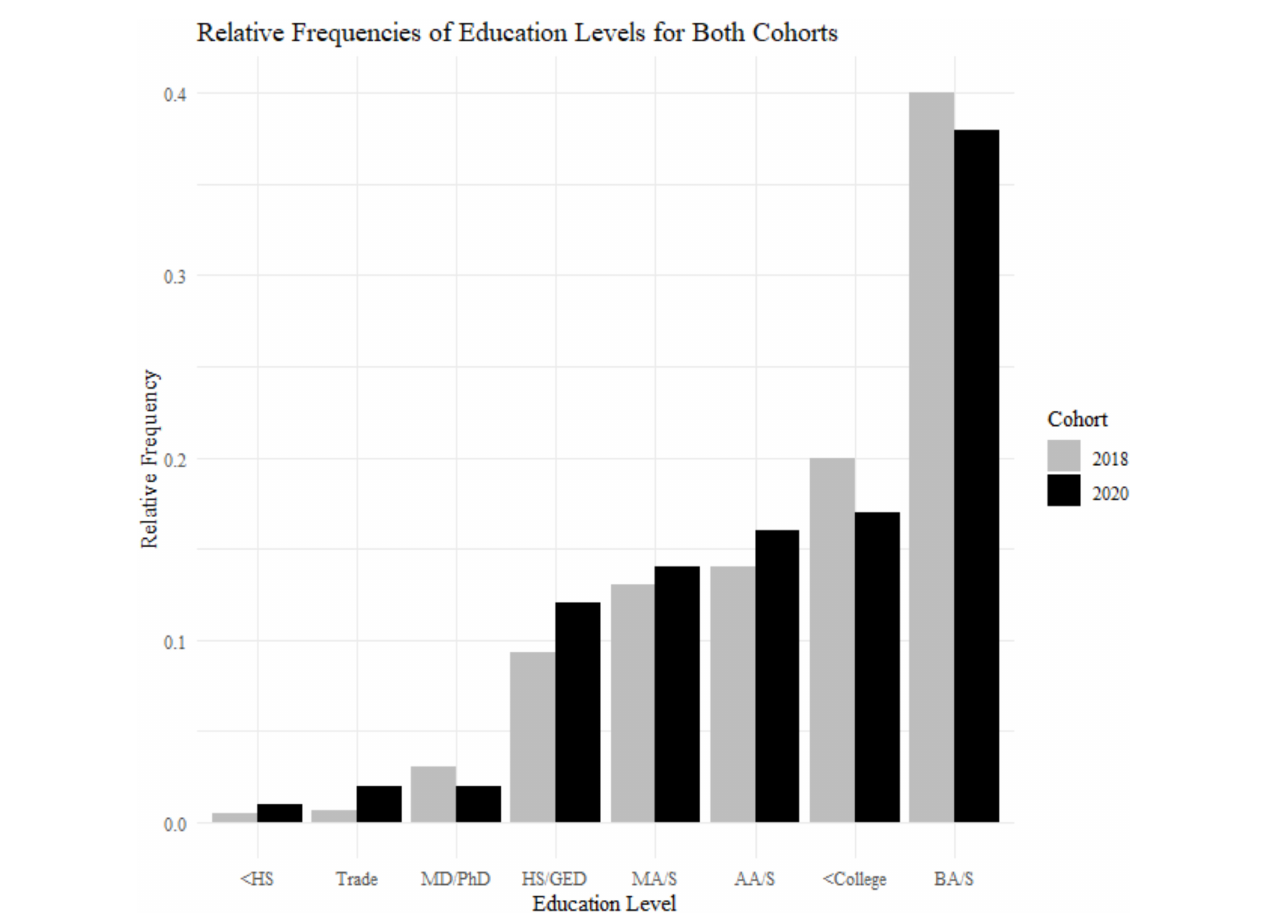
FIGURE2 Sample demographics: education levels for the 2018 cohort ( N = 799) and 2020 cohort ( N = 233). < HS, less than high school; HS/GED, high school or general educational development; < College, some college but no degree; Trade, equivalent of trade or professional certificate; AA/S, Associate of Art or Science; BA/S, Bachelor of Art or Science; MA/S, Master of Art or Science; MD/PhD, doctoral level degree.